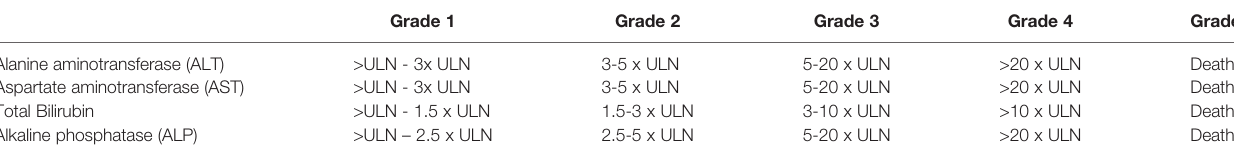
TABLE 2 | CTCAE Grading of hepatic adverse